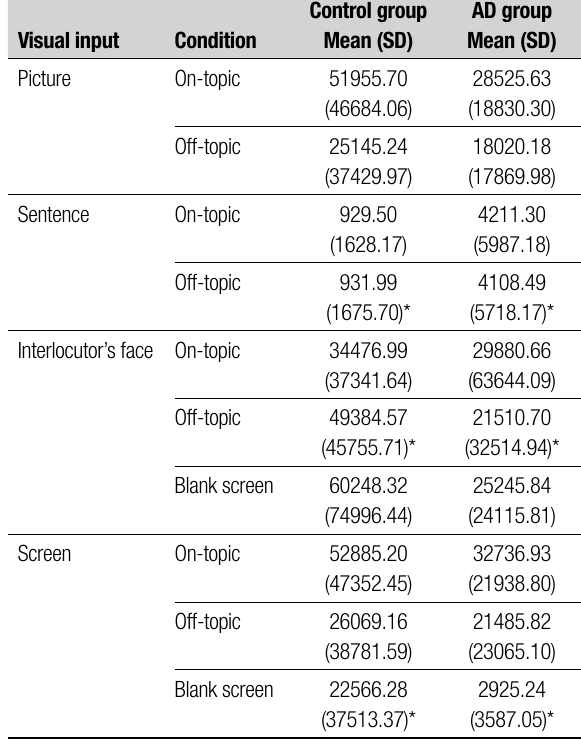
Table 1. Total fixation time on visual input in each